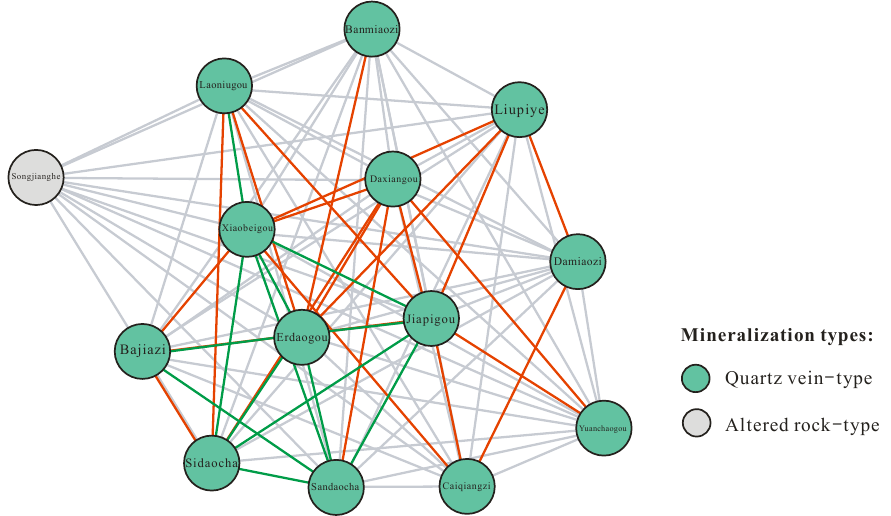
Figure 15. The clustering effect between typical deposits calculated by similarity. Colors of the connecting lines: green indicates similarity values ≥ 0.7, red indicates similarity values from 0.6–0.69, and gray indicates similarity values < 0.6.